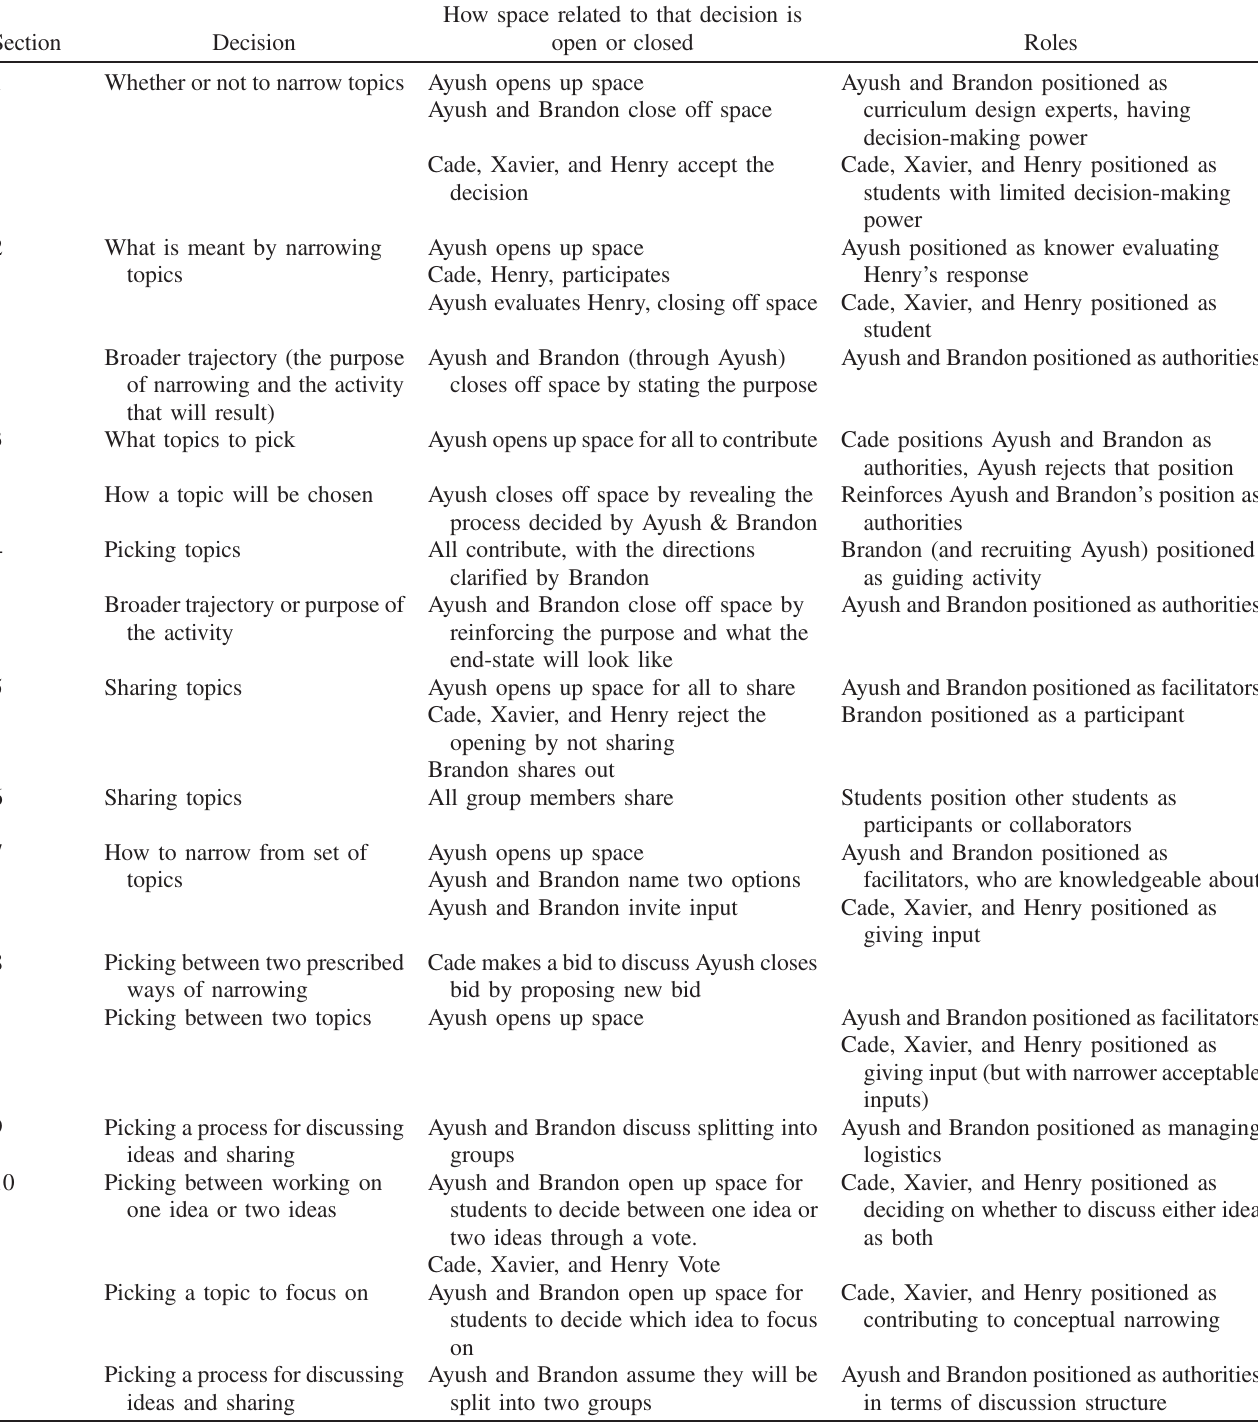
TABLE I. Summary of